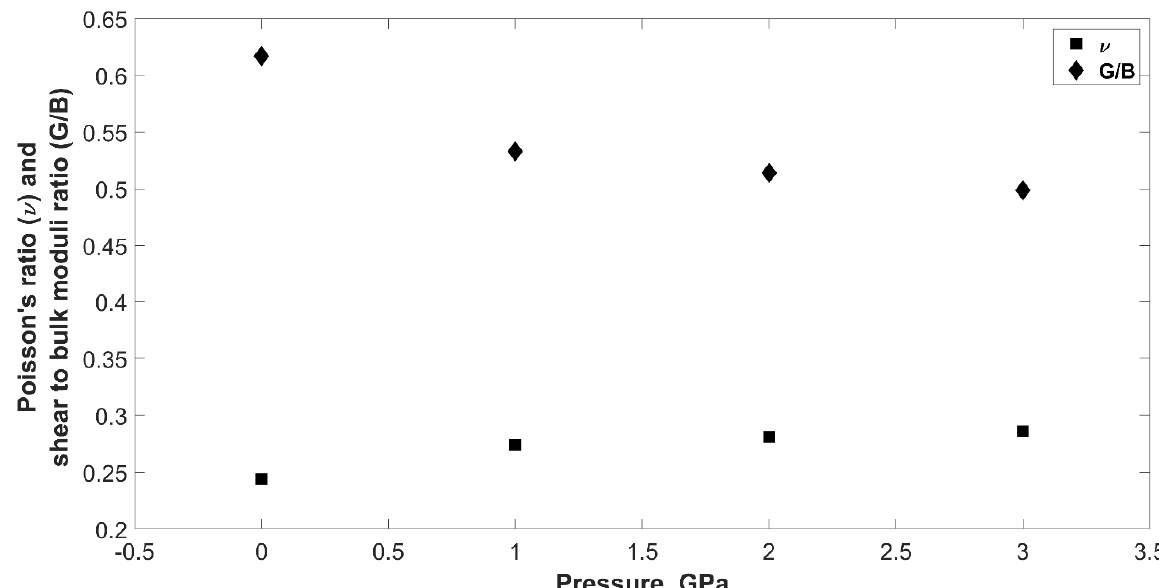
Figure 3. Pressure-dependent Poisson’s ratio ( ν ) and shear to bulk moduli ratio (G/B) of CO 2 -NH sH gas hydrate at 0 K.